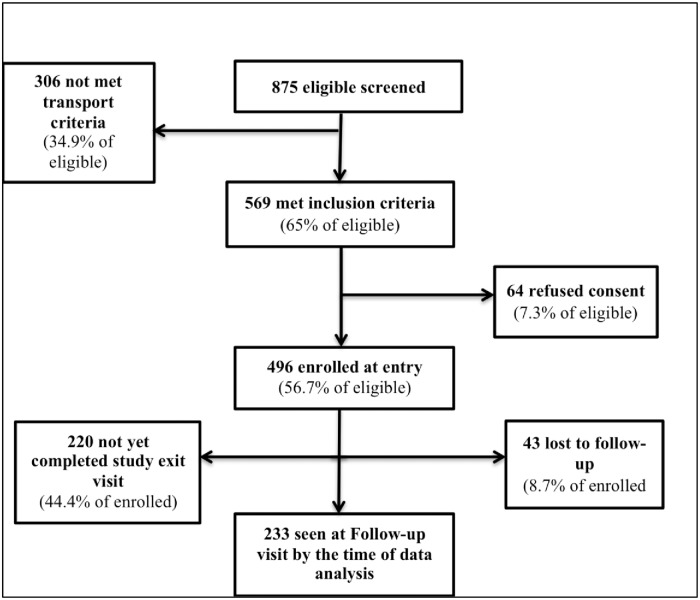
Screening, enrolment and follow-up of study participants.